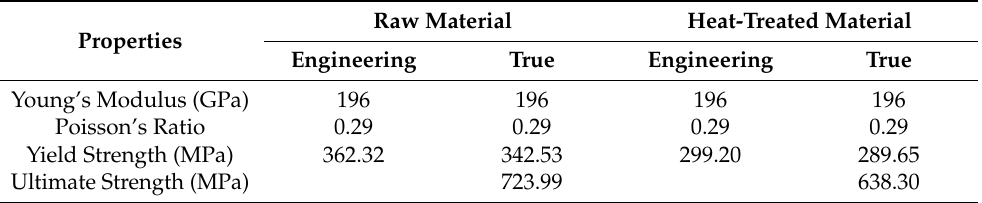
Figure 5. Stress-strain curves extracted by uniaxial compression tests: ( a ) compressive stress-strain curves of raw and spheroidized-annealed specimens; ( b ) compressive true stress-strain curve of spheroidized and annealed specimen. Table 3. Mechanical properties obtained by uniaxial compressive tests of AISI 1035 specimens.